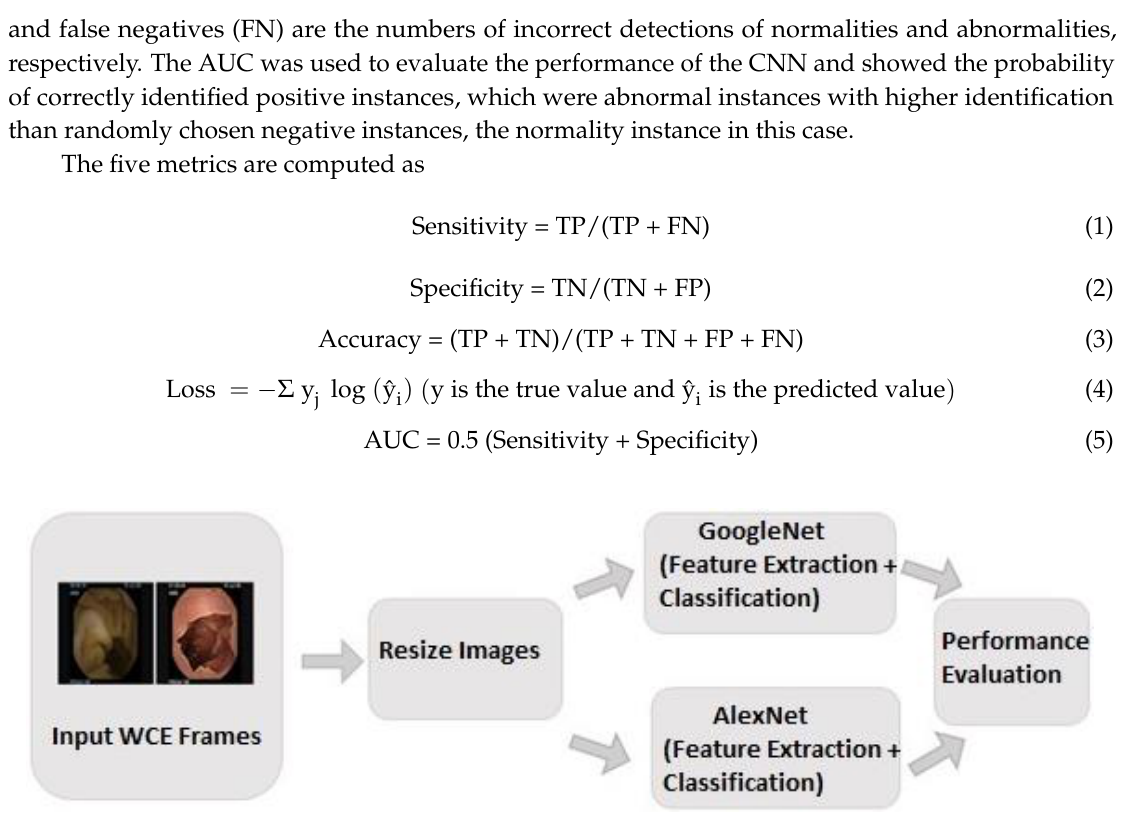
Figure 3. Schematic diagram of the overall system for ulcer detection.